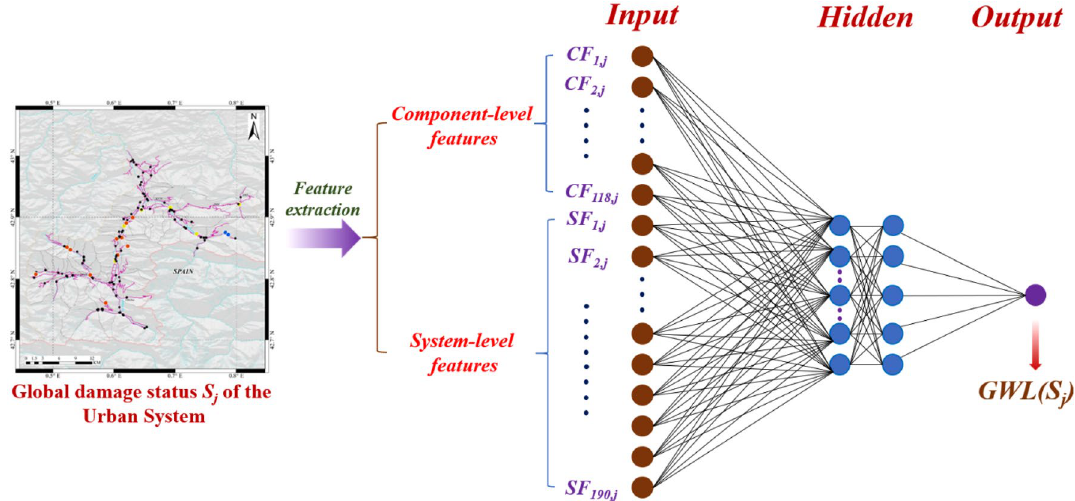
Figure 7. The architecture of the deep neural network. This plot illustrates how a “snapshot” of the damage status of the global RN can be translated into the set of “hybrid” features of the DNN , which can thereby foresee the corresponding GWL , from that status onwards. Besides, the learning-based strategy with the trained DNN will be employed to engender the experience dataset of better DNNs throughout training cycles, as well as the formation of rapid response strategies, when applied in the aftermath of real-world hazards. The map in the figure is plotted by